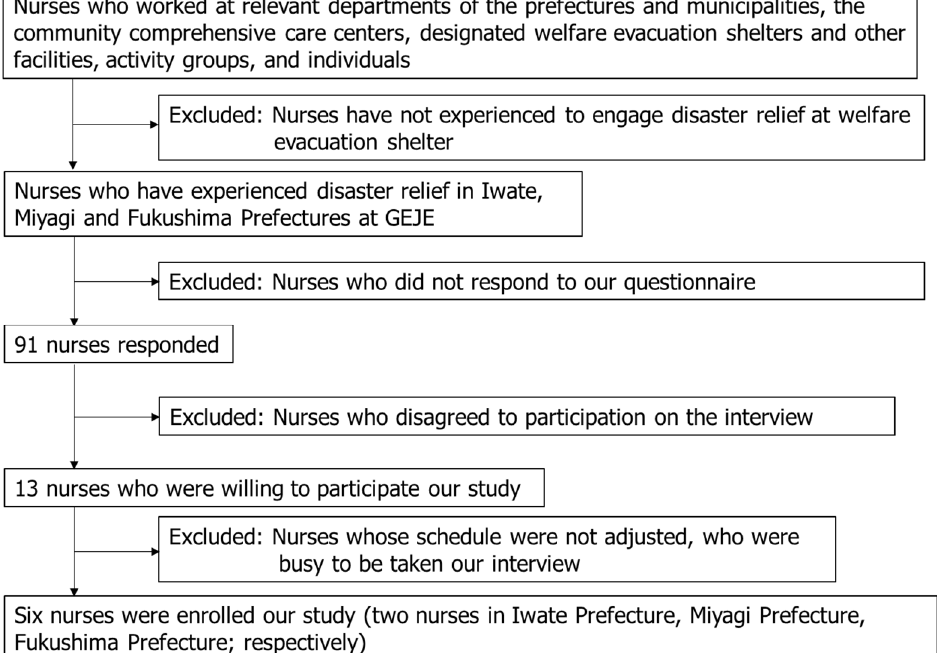
Figure 1. Enrollment of study participants .